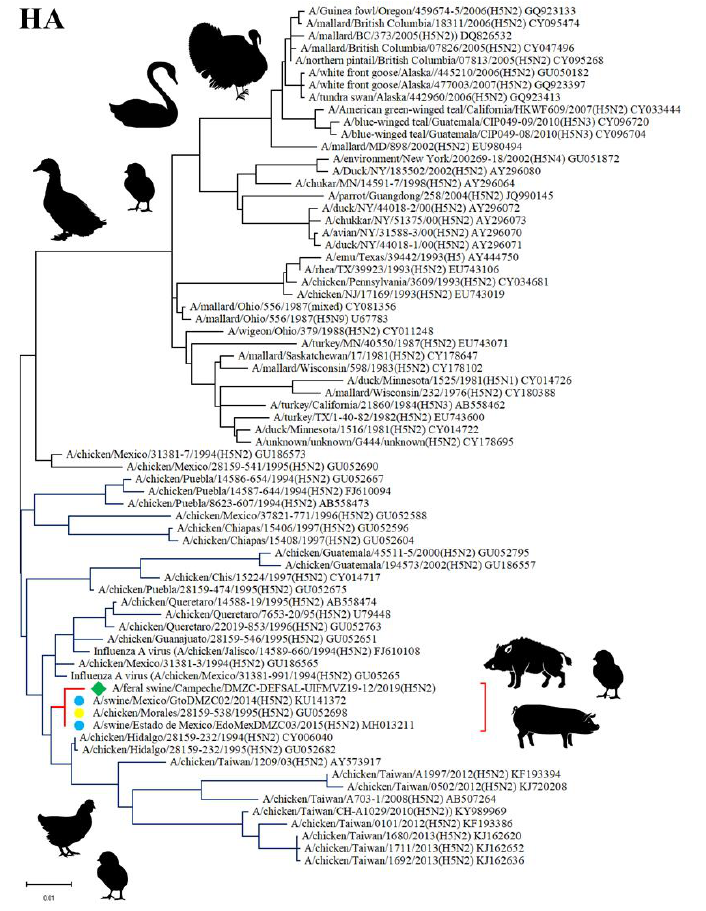
Figure 2. Phylogenetic tree of the HA gene of H5N2 influenza virus. The tree was drawn to scale, with branch length proportional to the number of substitutions per site. The H5N2 isolate herein reported is marked as 樊 , while swine H5N2 subtypes are marked as ●, and the avian H5N2 virus is marked as ●.